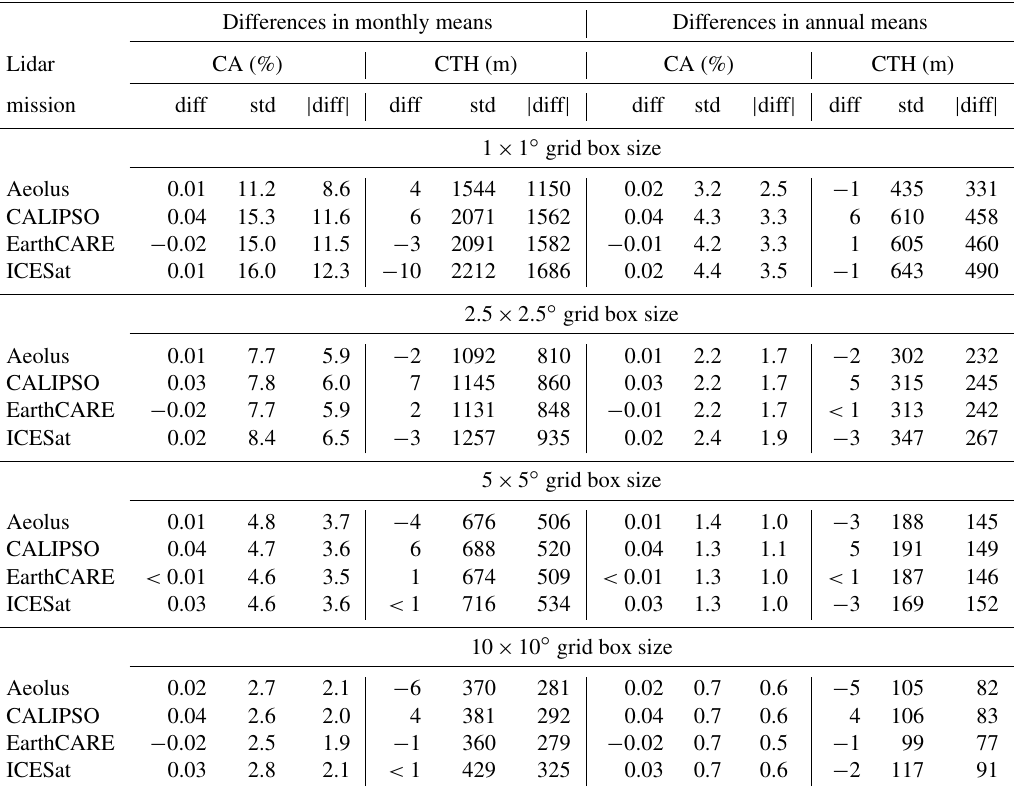
Table 2. Difference in mean global cloud amount (CA), and cloud top height (CTH) between a hypothetical 1d revisit mission, and the actual n day revisit. Single-year monthly and annual means for 2005–2016 are